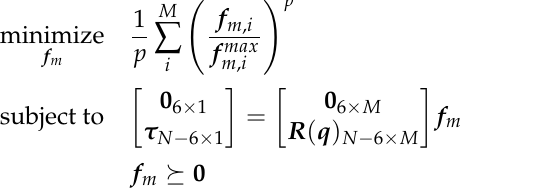
and moment τ w . total total operator is used to denote element-wise (cid:12)